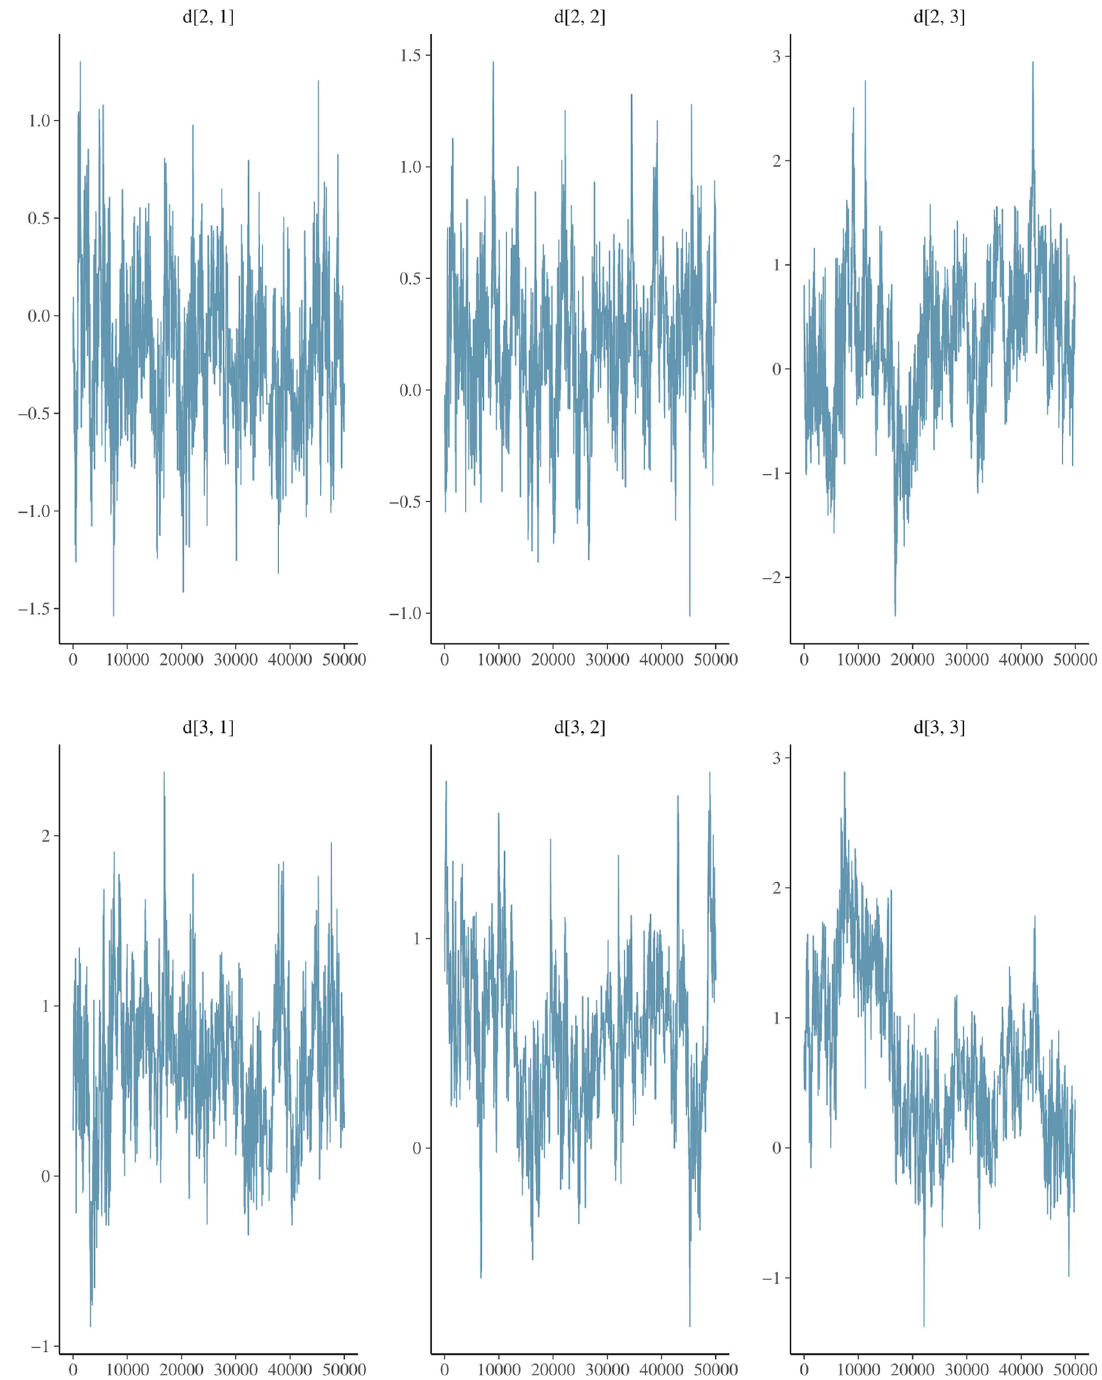
Fig 3. Home safety: Trace plots. The figure shows the trace plots of the pooled treatments effect against the baseline treatment Usual Care, after discarding the burnin.